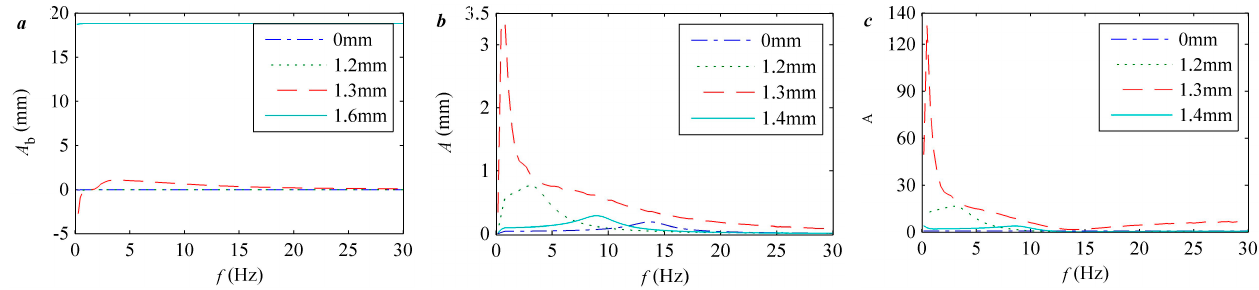
Figure 8. The simulation results for the ( a ) balance positions, ( b ) amplitudes of the tip displacement and ( c ) amplified factors for pretensions of 0 mm (dash-dot), 1.2 mm (dot), 1.3 mm (dash), and 1.6 mm (solid).